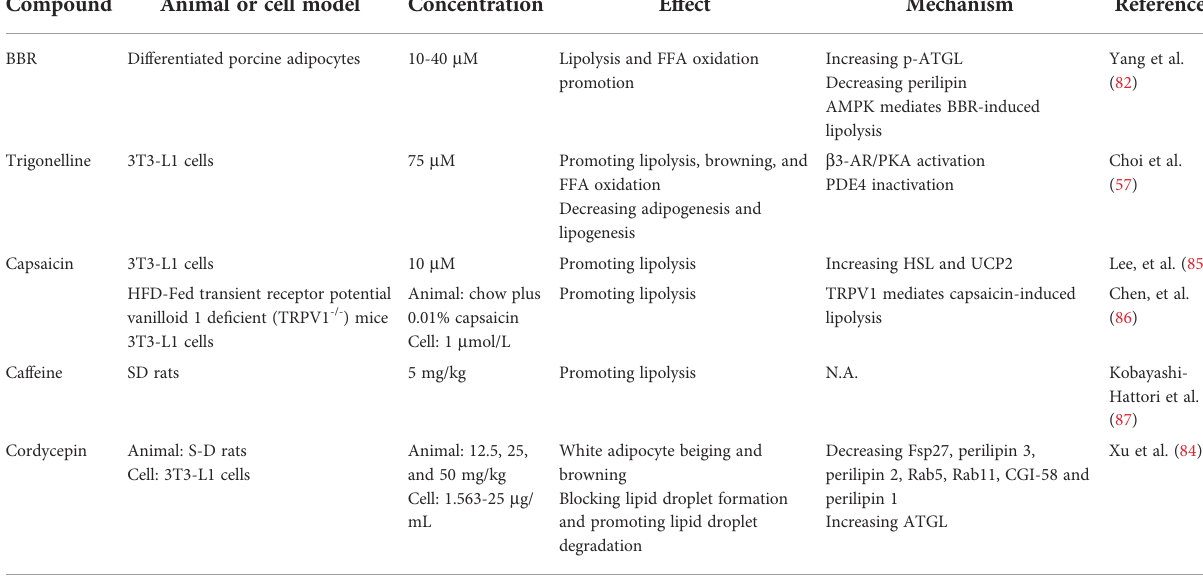
TABLE 2 Lipolytic effects and modes of action of